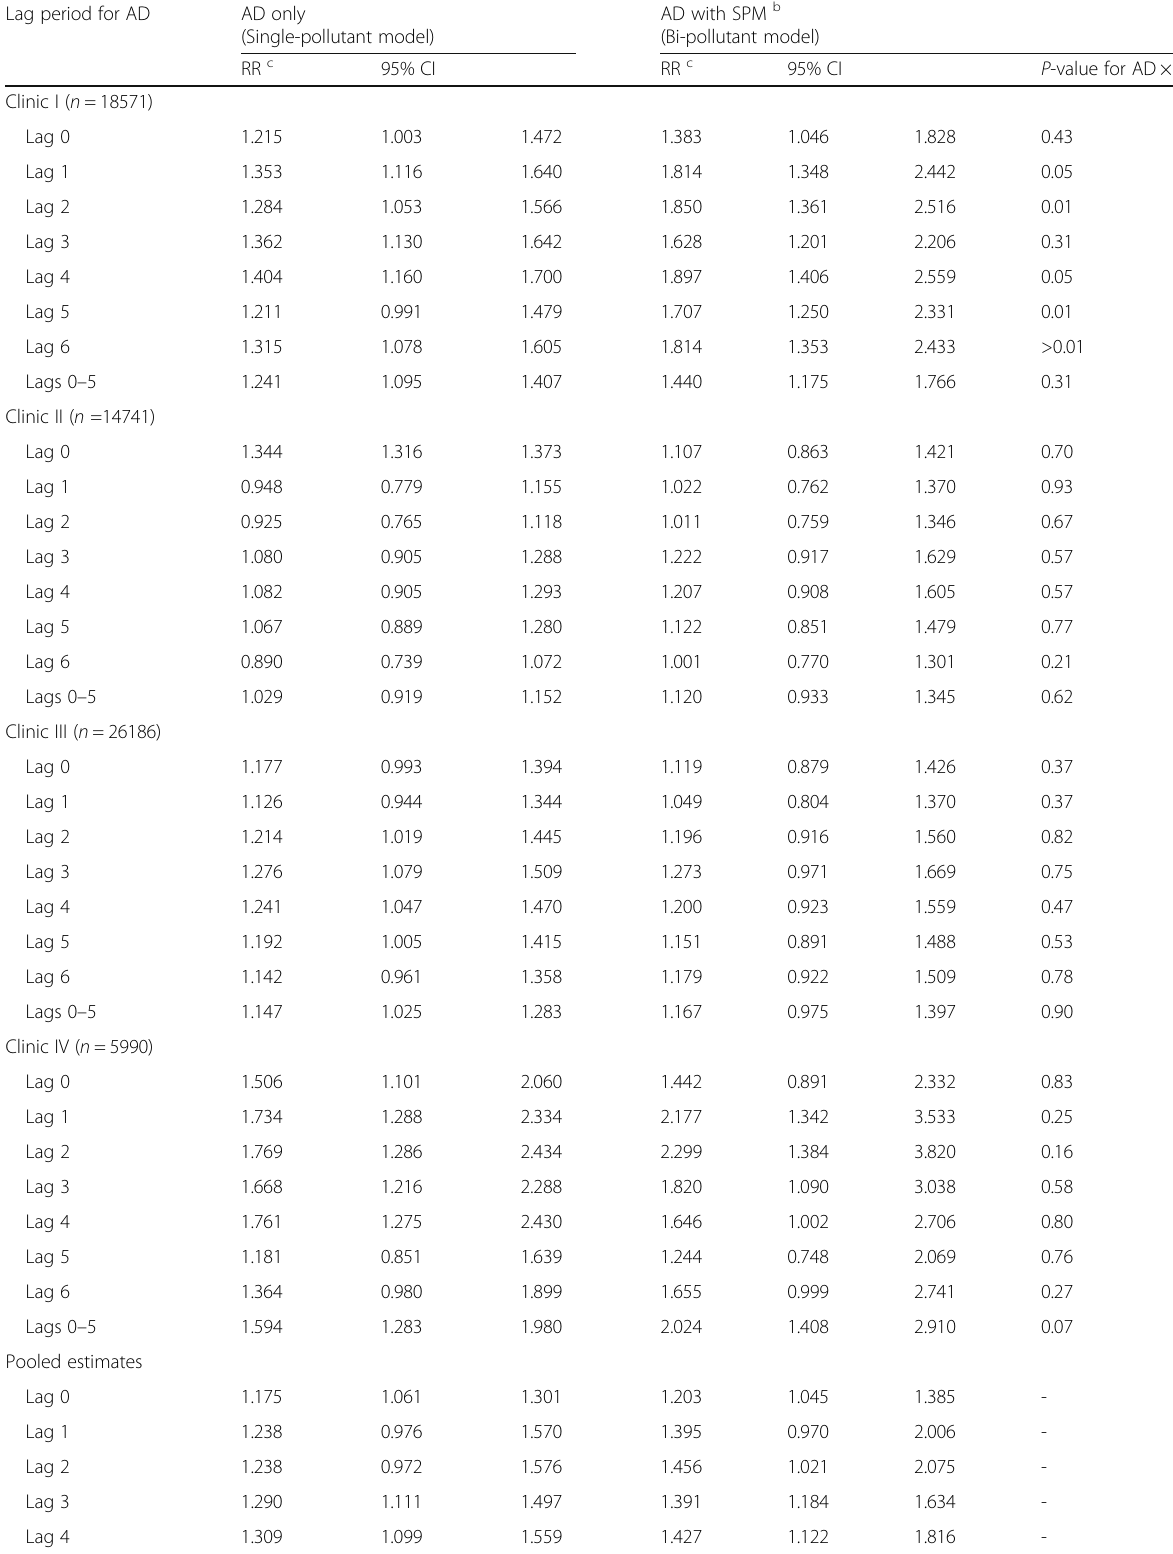
Table 2 Relative risks a and 95% confidence intervals for daily medical consultations for pollinosis in association with exposure to AD Lag period for